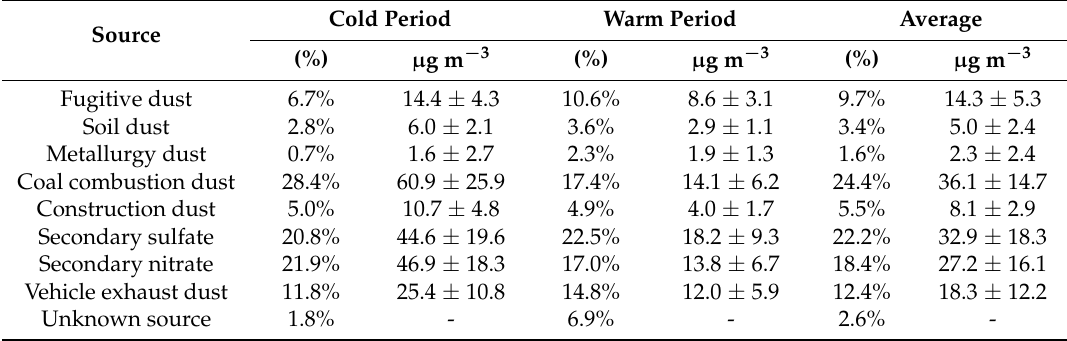
Table 2. Chemical mass balance source apportionment of ambient PM 2.5 in Xingtai in the cold and warm period, and the overall average